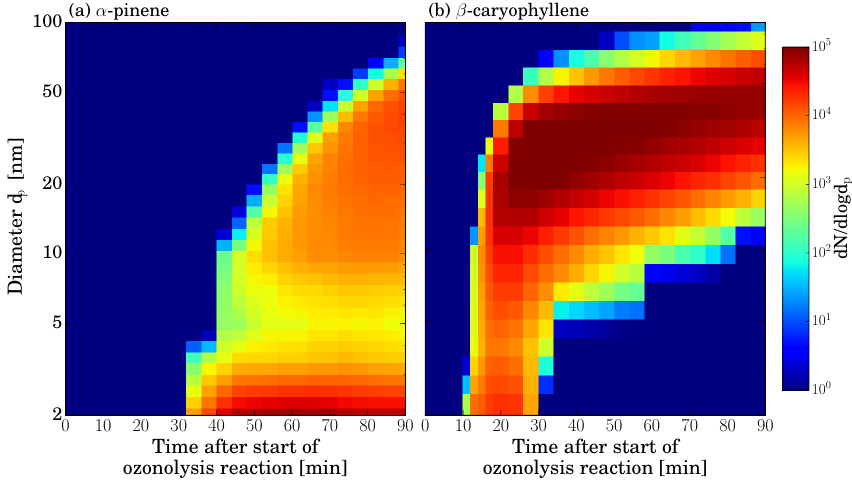
Figure 3. Combined, DMA train and SMPS data, showing size distribution evolution over time for the ozonolysis of two different VOCs. Panel (a) shows the α -pinene ozonolysis experiment and panel (b) the β -caryophyllene ozonolysis experiment. Transition between DMA train and SMPS measurement is at